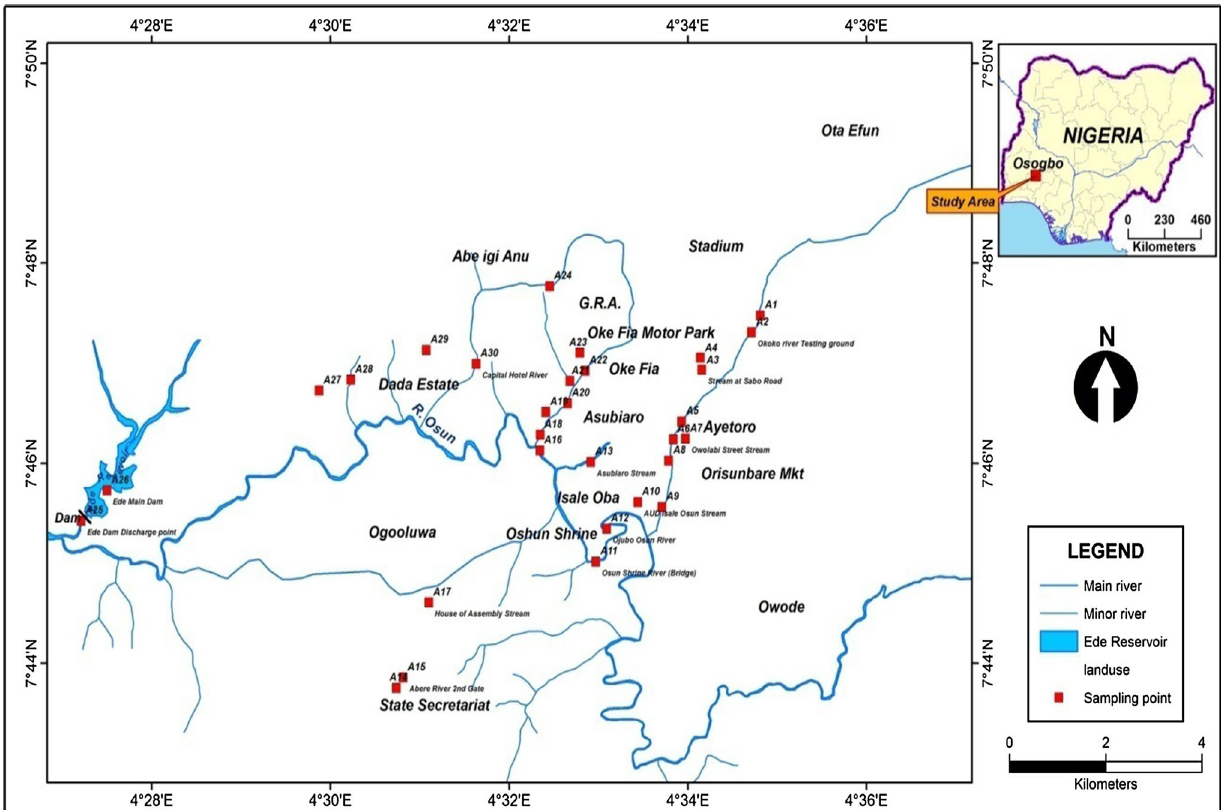
Fig. 2 Map of Osogbo metropolis showing the sampling